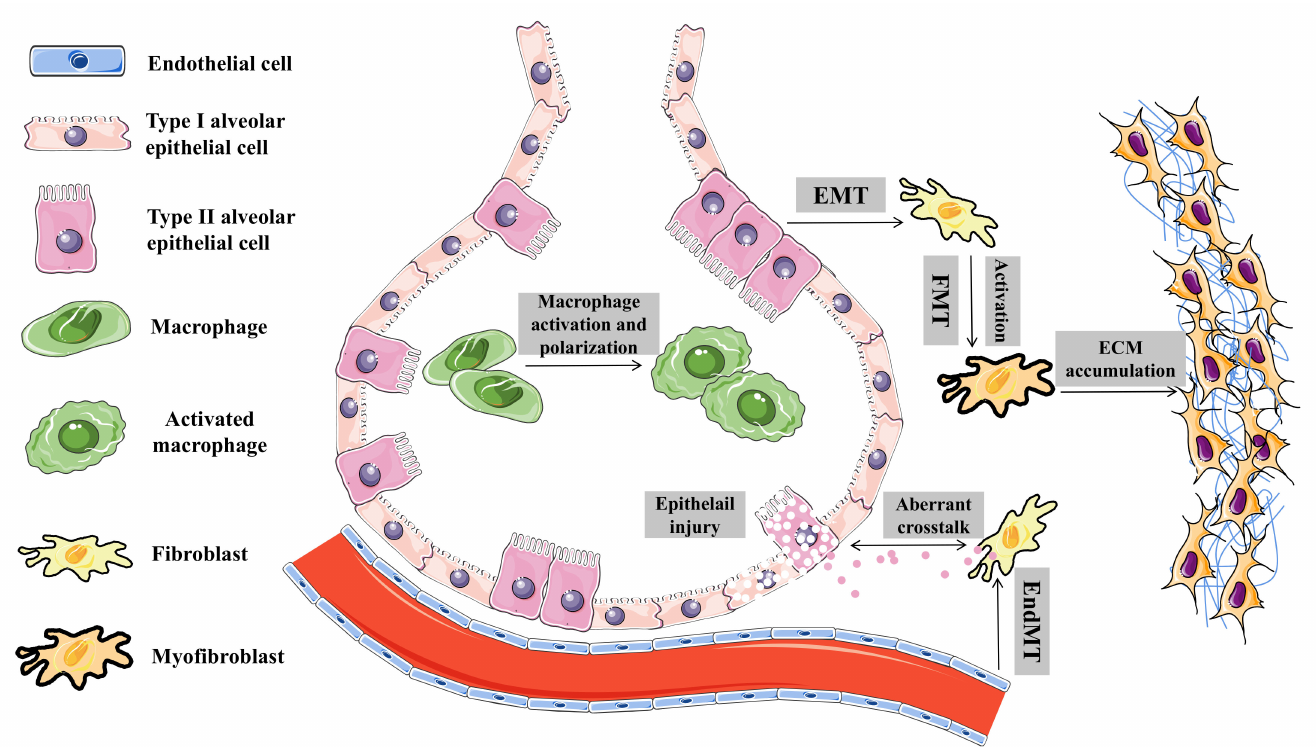
Figure 1. Pathophysiology of pulmonary fibrosis. Underlying pathophysiology of pulmonary fibrosis involves repetitive epithelial injury, epithelial-to-mesenchymal transition, macrophage activation, po- larization, persistent fibroblast activation, and fibroblast-to-myofibroblast transition and subsequent excessive deposition of extracellular